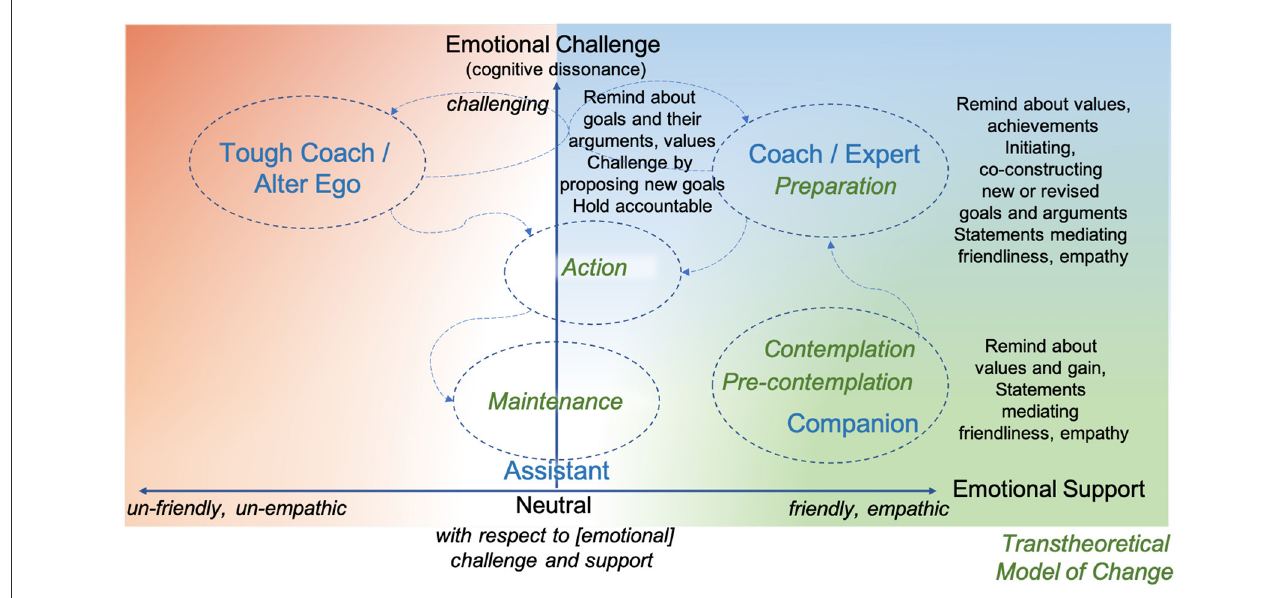
FIGURE1 Framework for mapping behaviors of a digital agent along two dimensions: emotional support (horizontal) and emotional challenge (vertical); to roles (blue) and to stages in the transtheoretical model for behavior change (TTM) (green), mapped out based on the results of study 1. The framework was applied and evaluated in studies 2 and 3. The arrows represent desirable transitions between TTM stages ending in a stable state of maintenance; there are also potential transitions between roles with a switch to the tough coach and back. The color scheme is inspired by compassion-focused therapy, which uses green to represent rest and comfort (soothing), blue for energy and action (drive), and red as a state of conflict (threat) (Gilbert, 2009). Desired actions provided by participants are